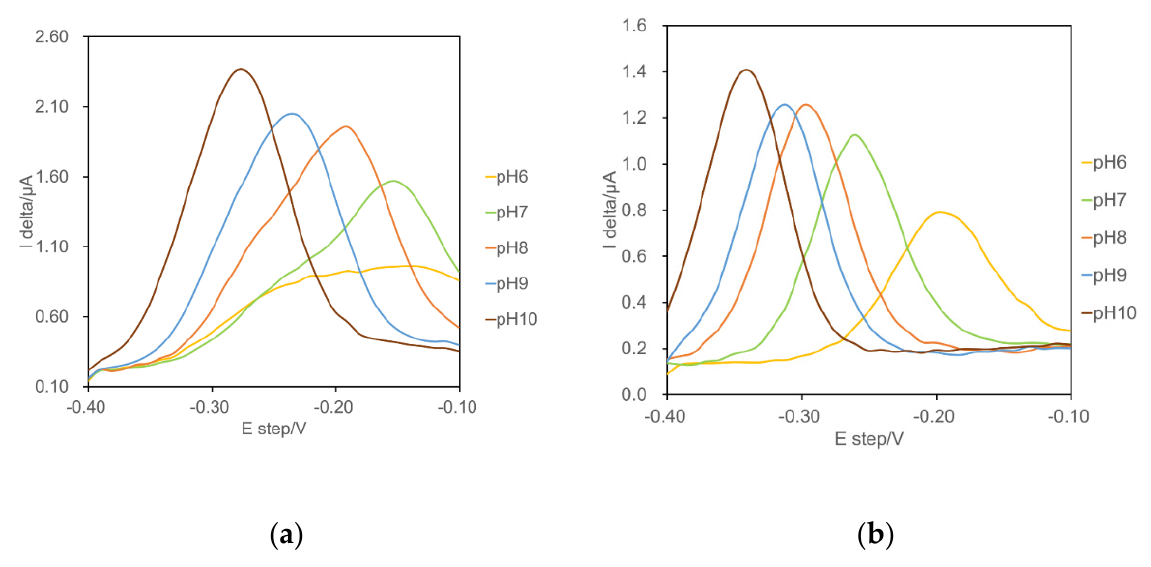
Figure 4. Square-wave voltammograms of an arPES-TBA immobilized electrode ( a ) and a methylene blue (MB)-TBA immobilized electrode ( b ) under several pH conditions.